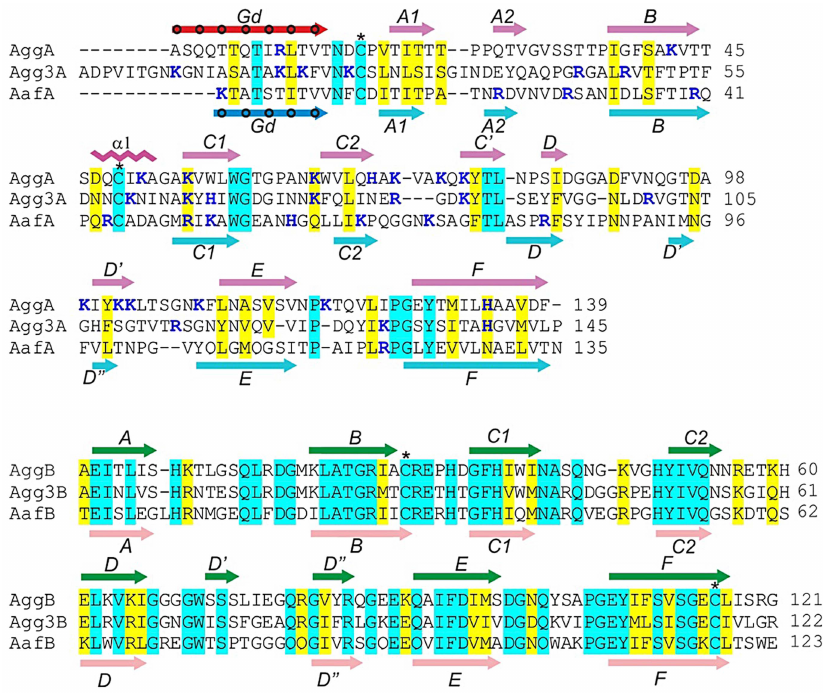
Figure 1. Sequence alignment of the major (AggA, AafA and Agg3A) and minor (AggB, AafB and Agg3B) subunits of aggregative adherence fimbriae (AAF) type I, II and III. Secondary structure elements of AggA, AafA, AggB, and AafB core structures are shown in magenta, cyan, green, and pink respectively, whilst the donor strands in AggA and AafA (Gd) are shown in red and blue, respectively. Donor residues occupying pockets of the acceptor cleft are indicated with circles. Amino acid identities and similar residues are indicated by background shading in cyan and yellow, respectively. The donor residues, occupying pockets of the acceptor cleft are indicated with circles. Positively charged residues are shown in bold and painted in blue. Cysteine residues involved in disulfide bonds are indicated with stars. CLUSTALW alignment of sequences was modified based on superposition of structures of the donor strand complemented (DSC) subunits AggA and AafA and AggB and AafB (this study).